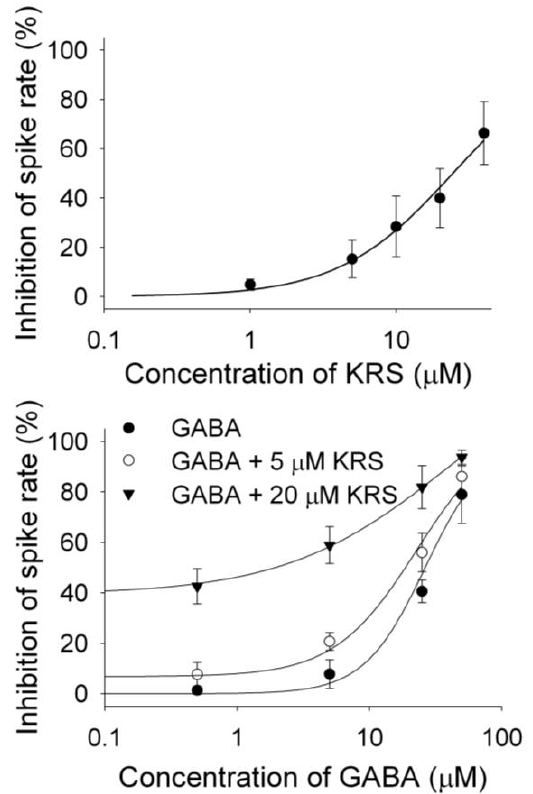
Figure 11. The concentration–response curves of KRS-5Me-4-OCF 3 –evoked inhibition and of GABA in the presence of KRS-5Me-4-OCF 3 . ( A ) The KRS-5Me-4-OCF 3 –evoked change in spiking rate was normalized to the control condition, and then averaged. Each point was the mean value  SEM of 4 to 7 cells. The line is fit for the data to the Hill equation: y = Y 0 + Ax n /( K dn + x n ), where y is the inhibition of spiking rate, Y 0 is minimal inhibition, A is maximal inhibition, K d is the apparent dissociation constant for agents, and n is the Hill coefficient. K d and n were estimated using a Marquadt nonlinear least-squares routine. ( B ) Shift of the concentration–response curves of GABA in the presence of KRS-5Me-4-OCF 3 at different concentrations (0, 5, 20 μM). The lines are fits for the data to the above Hill equation. From